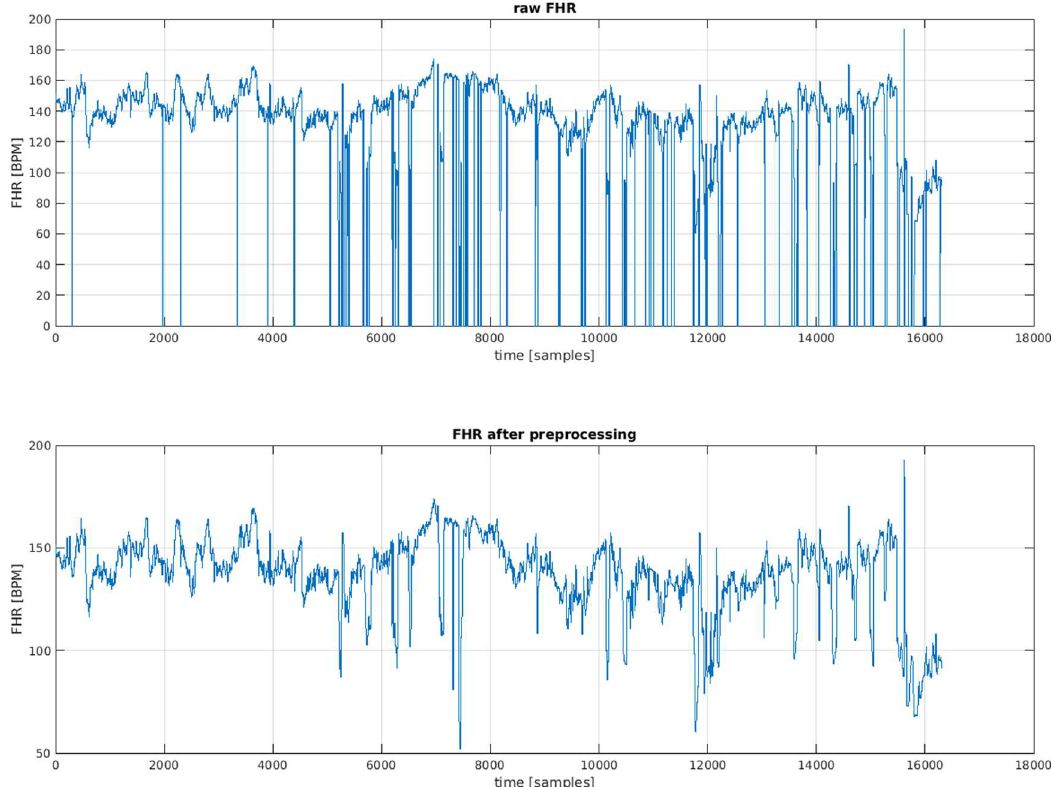
Fig 1. Comparison between a raw FHR signal and the signal obtained after